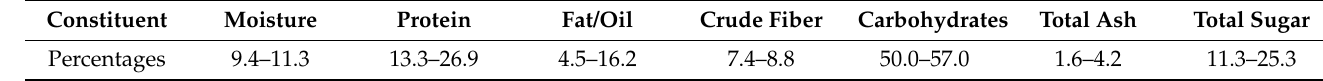
Table 2. Percentages of chemical compounds present in tamarind